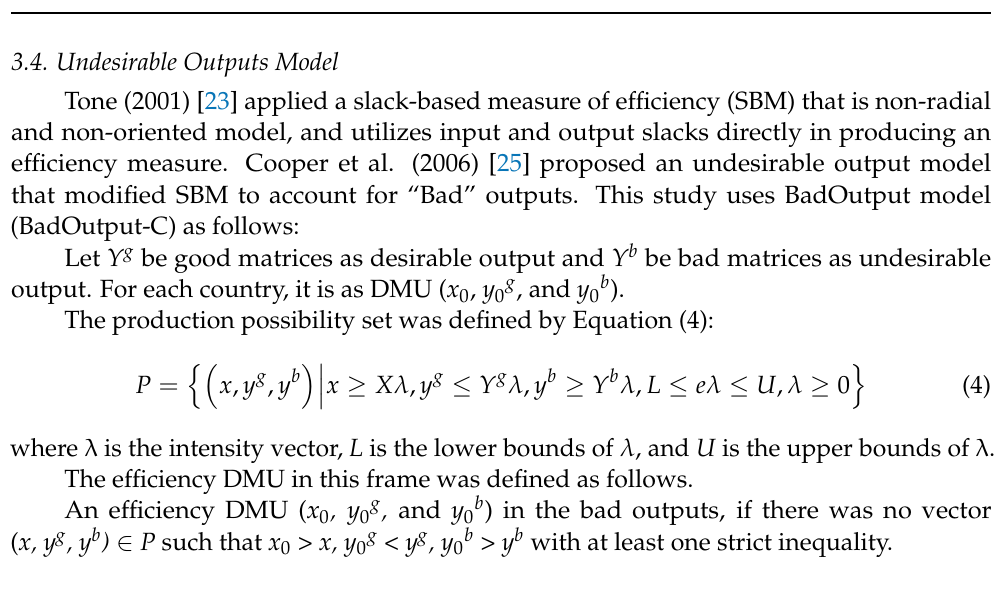
Table 2. List of inputs, desirable outputs, and undesirable outputs selected. Inputs Desirable Outputs Undesirable Outputs Energy consumption from coal, oil, gas